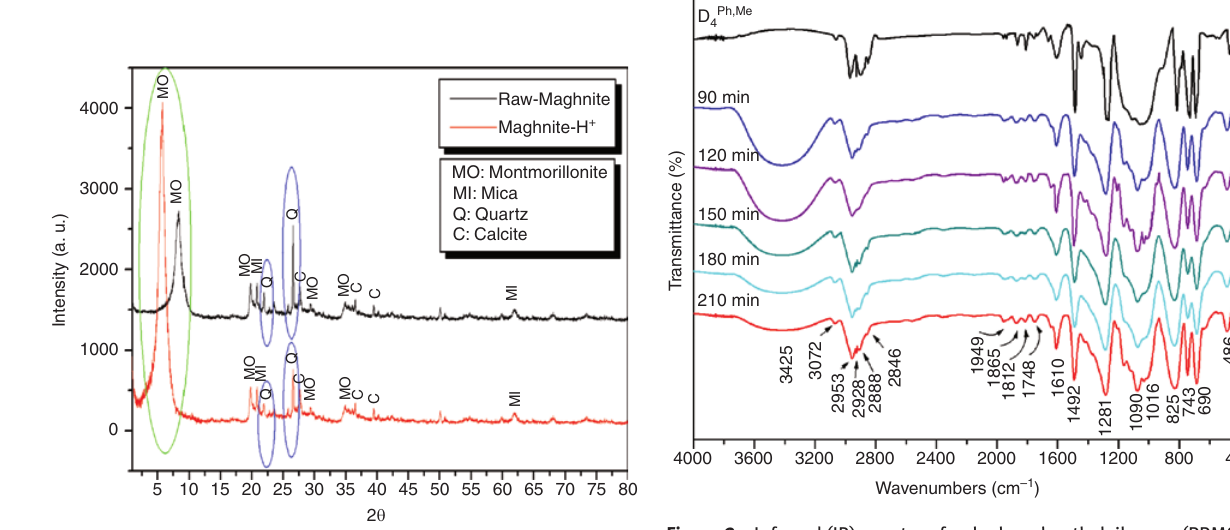
Figure 1: X-ray diffraction (XRD) patterns of the Maghnite before treatment (raw-Maghnite) and after treatment (Maghnite-H + ).